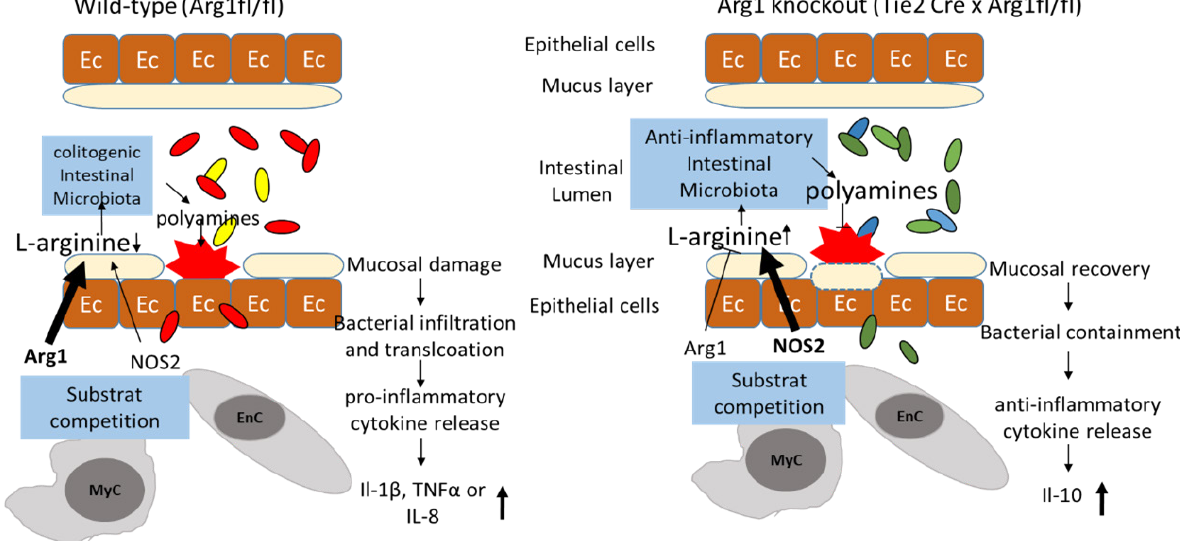
Figure 2. The availability of intraluminal L -arginine and subsequent changes in the composition of the intestinal microbiota: the availability of intraluminal L -arginine influences the bacterial diversity between wild-type mice (left panel) and mice with an Arg1 knockout in endothelial and hematopoietic cells ( Tie2-Cre x Arg1 fl/fl ; right panel). Once colitis is established, the increased expression of Arg1 in intestinal tissues accelerates the consumption of L -arginine, subsequently resulting in reduced diversity of intestinal microbiota. In contrast, intraluminal L -arginine is more available in Tie2-Cre x Arg1 fl/fl mice, due to the lack of consumption by Arg1 in endothelial and myeloid. Commensal bacteria known for human health are increased in Tie2-Cre x Arg1 fl/fl mice, metabolize L -arginine into polyamines and induce mucosal healing Note. Adapted from “Arginase impedes the resolution of colitis by altering the microbiome and metabolome” by Baier J, Gänsbauer M, Giessler C, Arnold H, Muske M, Schleicher U, et al. J Clin Invest. 2020;130:5703-20